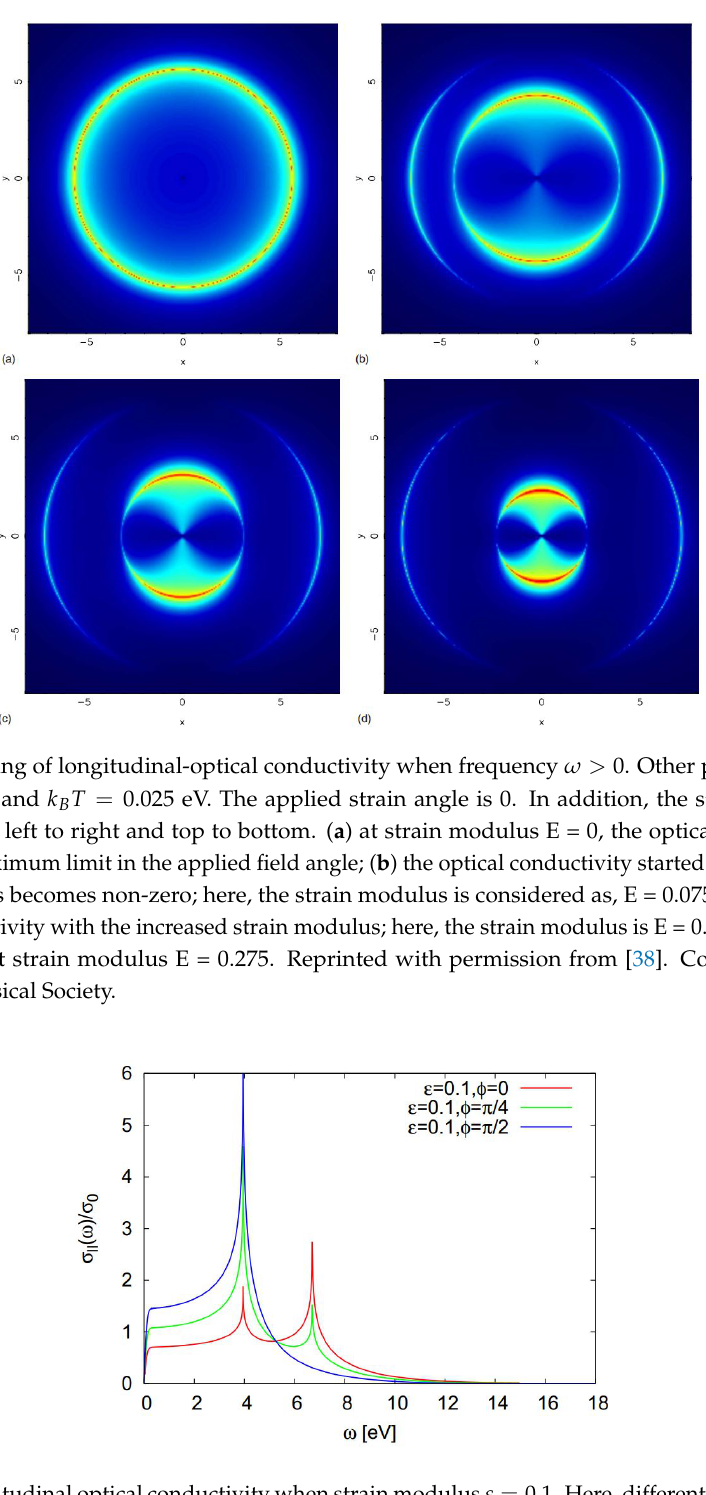
Figure 6. Longitudinal optical conductivity when strain modulus ε = 0.1. Here, different lines represent the orientation variation of different electric fields ( φ = 0, π /4, π /2). Reprinted with permission from [38]. Copyright (2010) American Physical